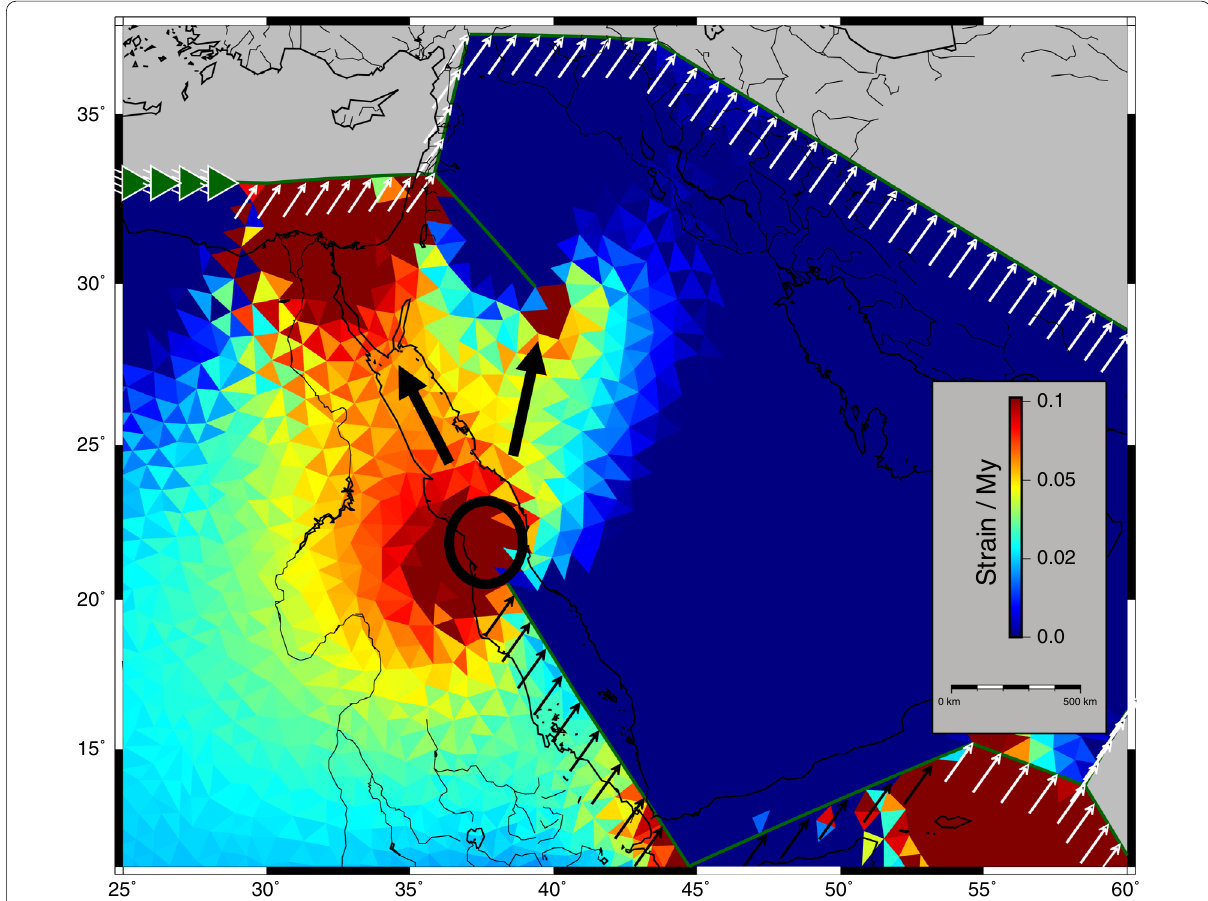
Fig. 6 Strain rate map that correspond to the change of the SRS and Gulf of Aden kinematic conditions (black arrows). The strain distribution here reflects the boundary conditions corresponding to the time interval between initiation of dike intrusion along the Red Sea (24 Ma) until the development of the Dead Sea Transform (20 Ma). The dilatational strain rate localizes along the NRS. For simplicity, we are use a homogenous elastic domain in which the dilatational strain tends to be uniformly distributed. The black circle highlights the location of the hypothesized central RS triple junction. The black arrows represent the northern two arms, the MMTZ transform and NRS